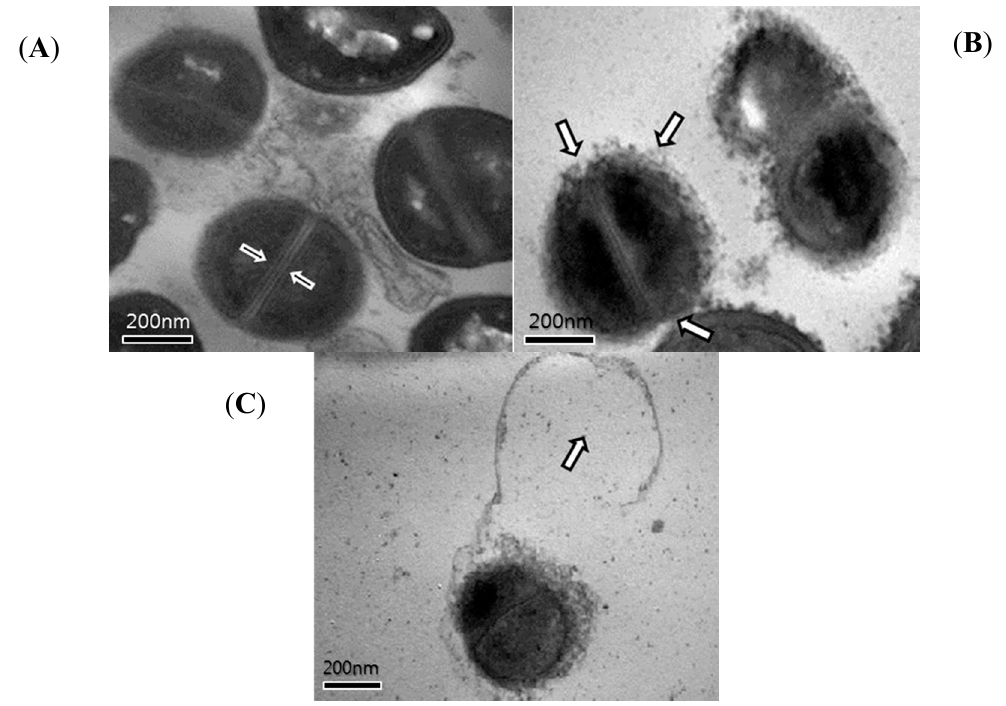
Figure 6. Transmission electron microscopy (TEM) images of methicillin-resistant Staphylococcus aureus (MRSA) ( A – C ) after 24 h of curcumin treatment. (A) Untreated control MRSA. These arrows indicate intact septa. (B) MRSA treated with 1/2 MIC of curcumin (125 µg/mL). These arrows indicate damage of cytoplasmic membrane. (C) MRSA treated with the MIC of curcumin (250 µg/mL). This arrow indicates a dividing cell following exposure to